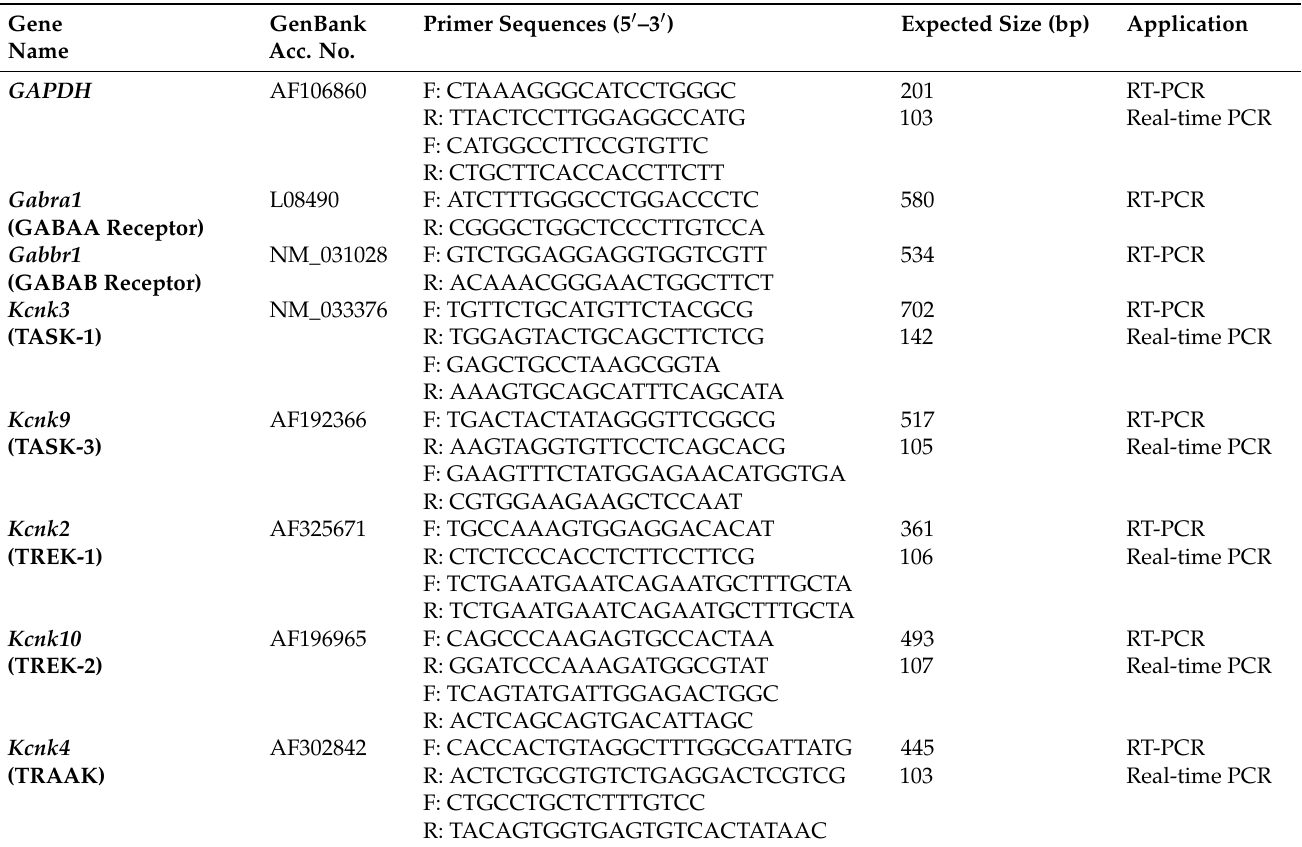
Table 1. Gene primer sequences used for